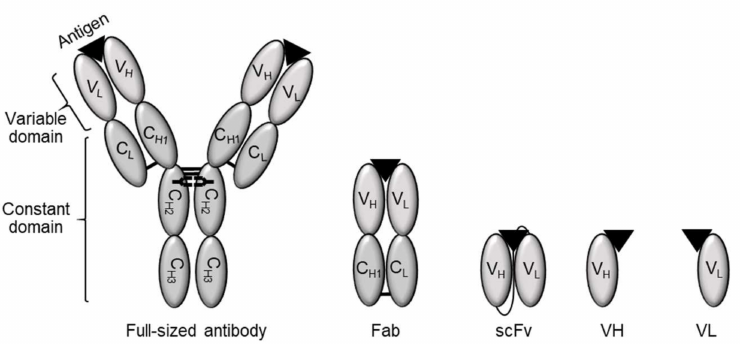
Figure 1. Schematic representations of full-sized antibody, antigen-binding fragment (Fab), single chain variable fragment (scFv), variable heavy chain (VH), and variable light chain